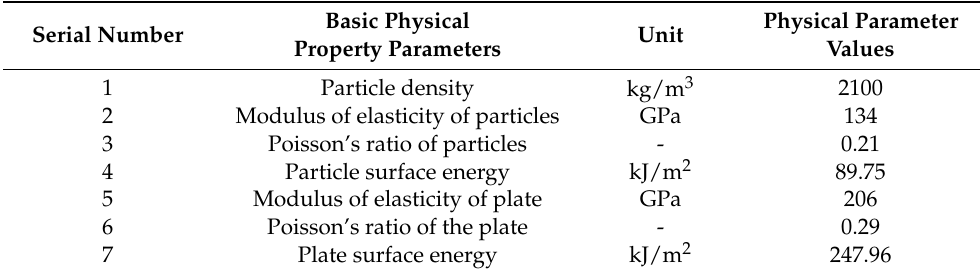
Table 2. Basic physical properties of coal ash particles and flat